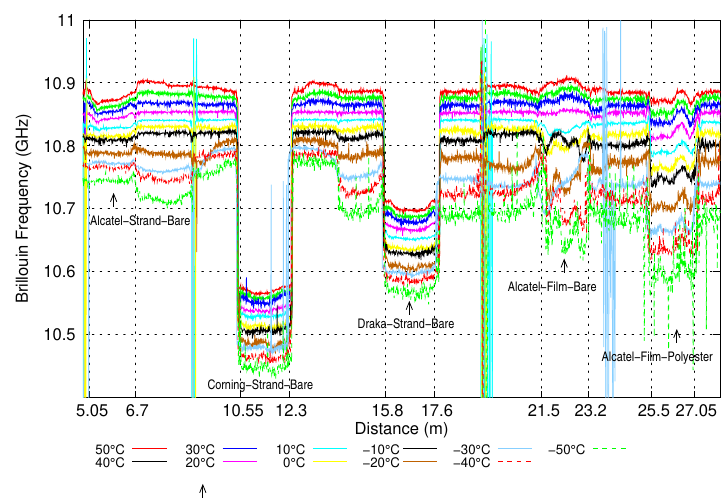
Figure 8. Variation of the Brillouin frequency of straps with temperature.